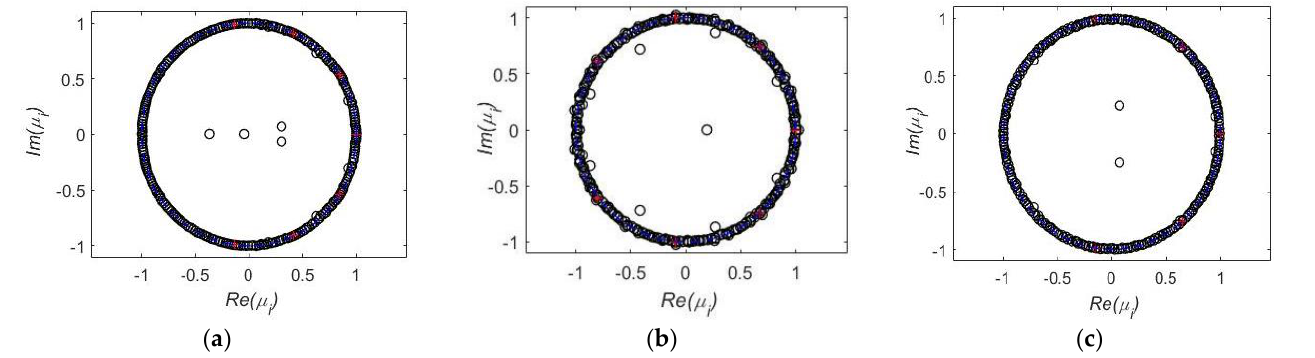
Figure 13. The DMD eigenvalues. The black circles denote the eigenvalues obtained using the original DMD and the red crossings denote the eigenvalues obtained using the SPDMD: ( a ) L / D = 1.8, ( b ) L / D = 2.5, ( c ) L / D = 3.